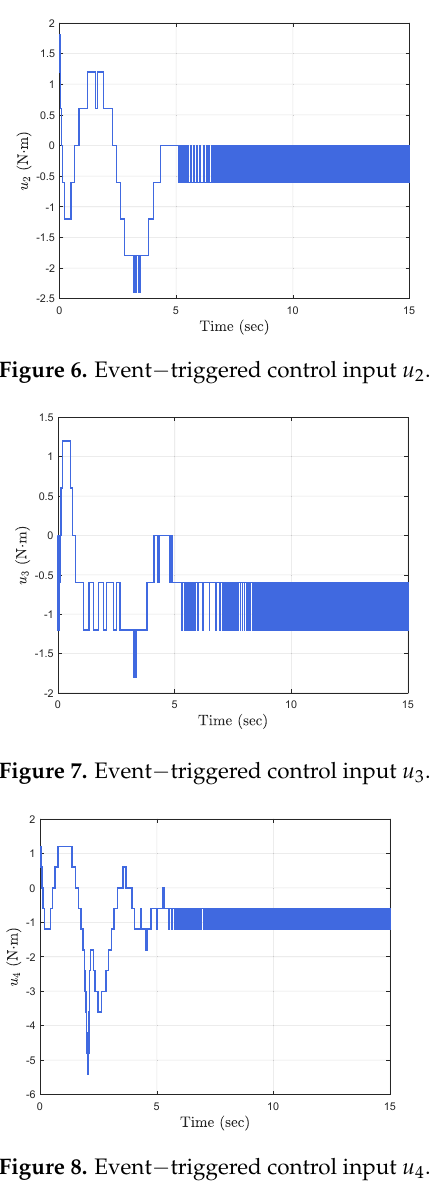
Figure 5. Event − triggered control input u 1 .